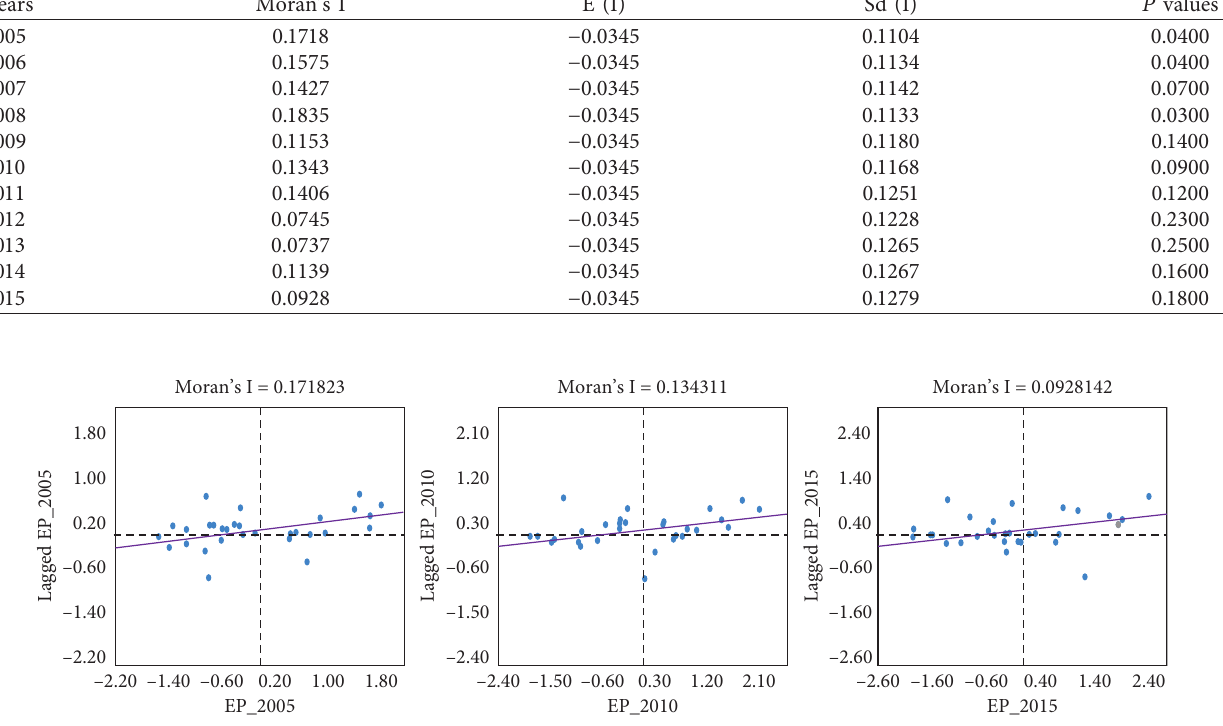
Figure 2: Moran scatterplots of environmental pollution in China.